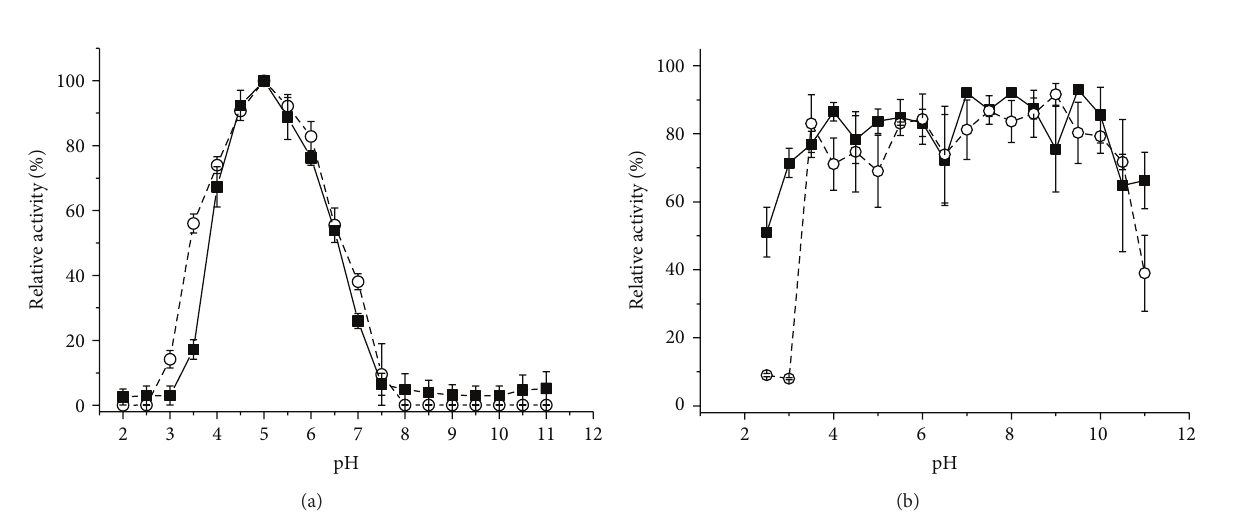
Figure 6: Effect of pH on the activity of the 𝛽 -glucosidases from the crude extract from M . heterothallica F.2.1.4. (a) ( ◼ ) SSCWB and ( I ) SmCP, respectively. Effect of the pH on the stability of the 𝛽 -glucosidases. (b) ( ◼ ) SSCWB and ( I ) SmCP,